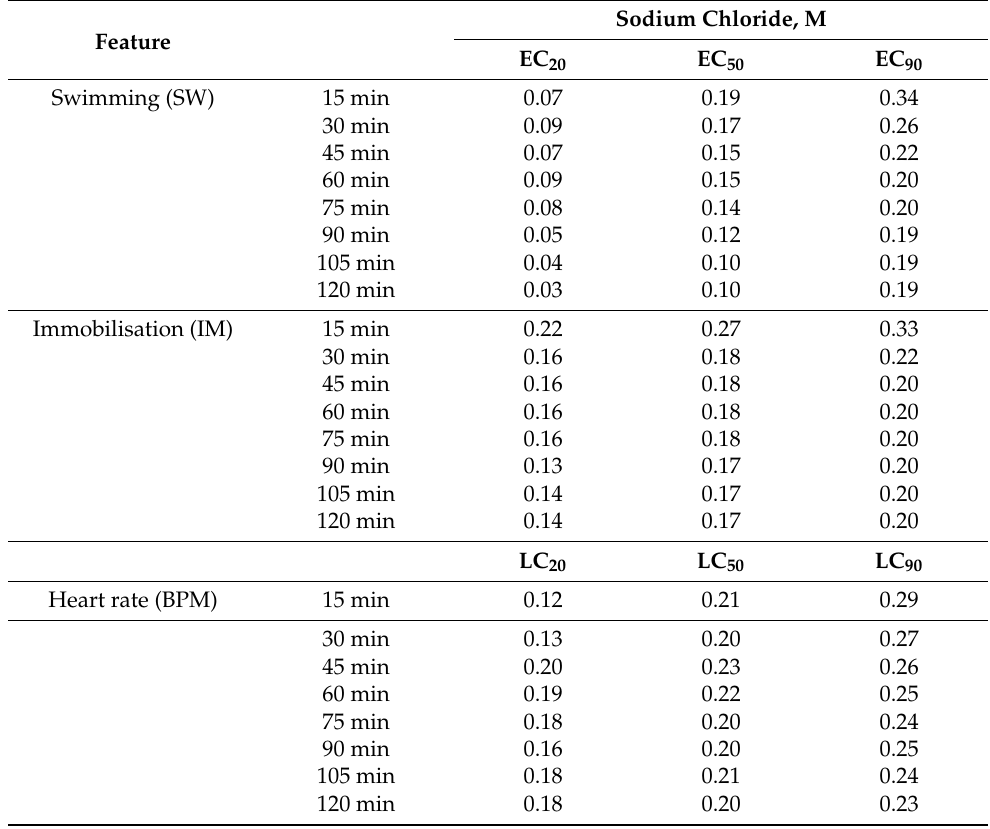
Table 7. Effect of sodium chloride (NaCl) on swimming (SW), immobilisation (IM) and heart rate (BPM) of crustaceans Daphnia magna